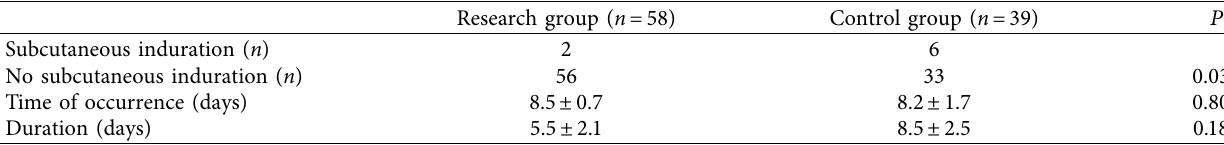
Table 2: Cases of subcutaneous induration.